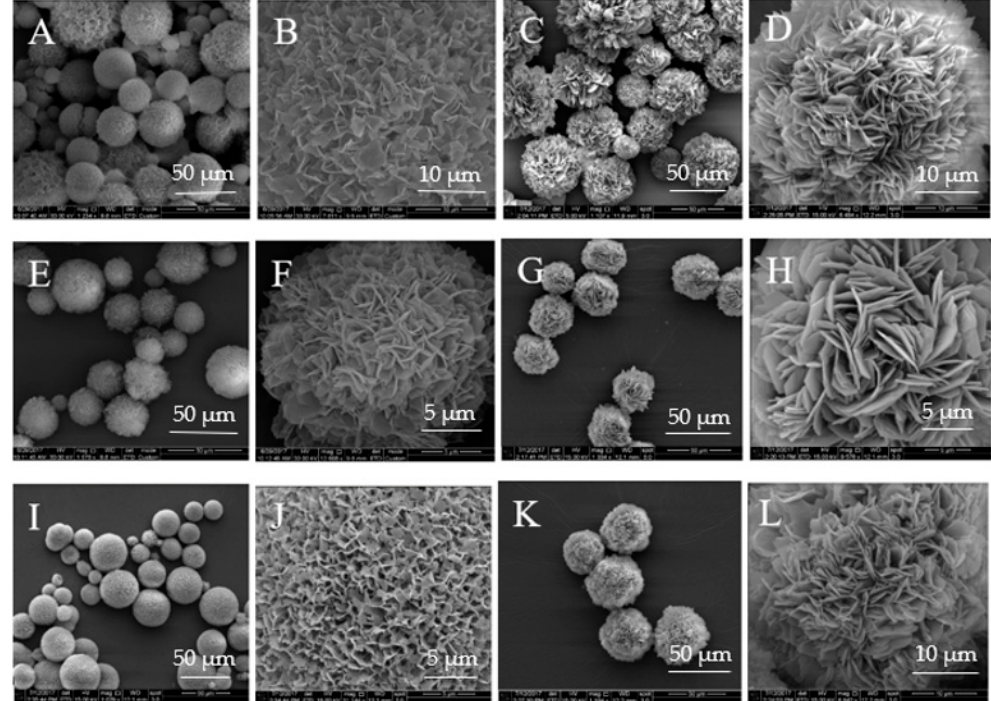
Figure 3. SEM images of L-glu spheres and sphere surfaces crystallized using high ( A , B ) and low ( C , D ) concentrations of barium ions, L-glu spheres and sphere surfaces crystallized using high ( E , F ) and low ( G , H ) concentrations of strontium ions and L-glu spheres and sphere surfaces crystallized using high ( I , J ) and low ( K , L ) concentrations of calcium ions.